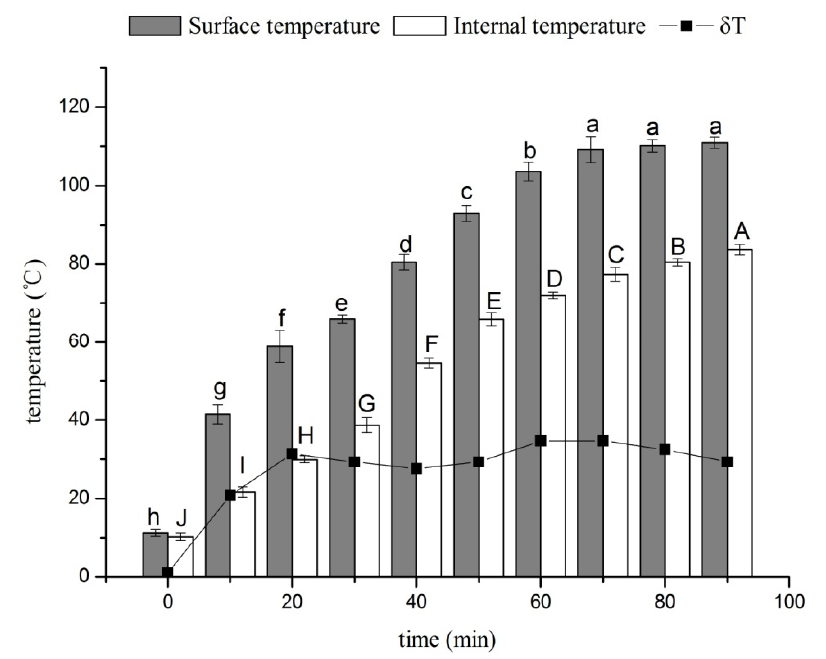
Figure 1. Variation of the surface temperature and internal temperature during drying. Note: Different uppercase/lowercase letters means differ significantly (p < 0.05).